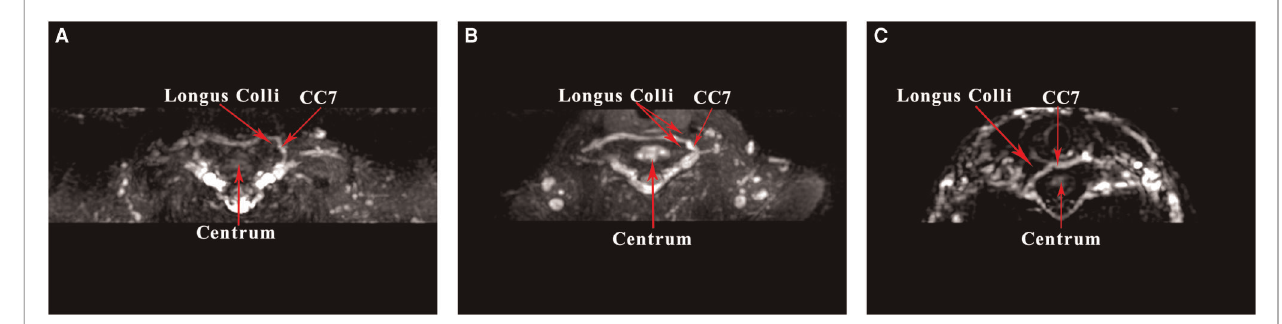
FIGURE 1 | contralateral cervical 7 (CC7) nerve transfer operation on MRI by 3D CUBE-STIR sequences: ( A ) anterior route, ( B ) middle route, ( C )